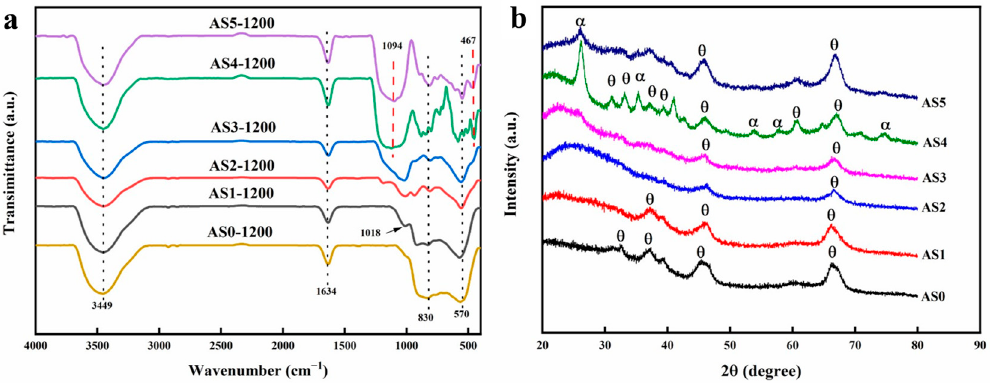
Figure 6. FTIR spectra ( a ) and XRD pattern ( b ) of all AS samples after heat treatment at 1200 °C. ( b ) of all AS samples after heat treatment at 1200 ◦